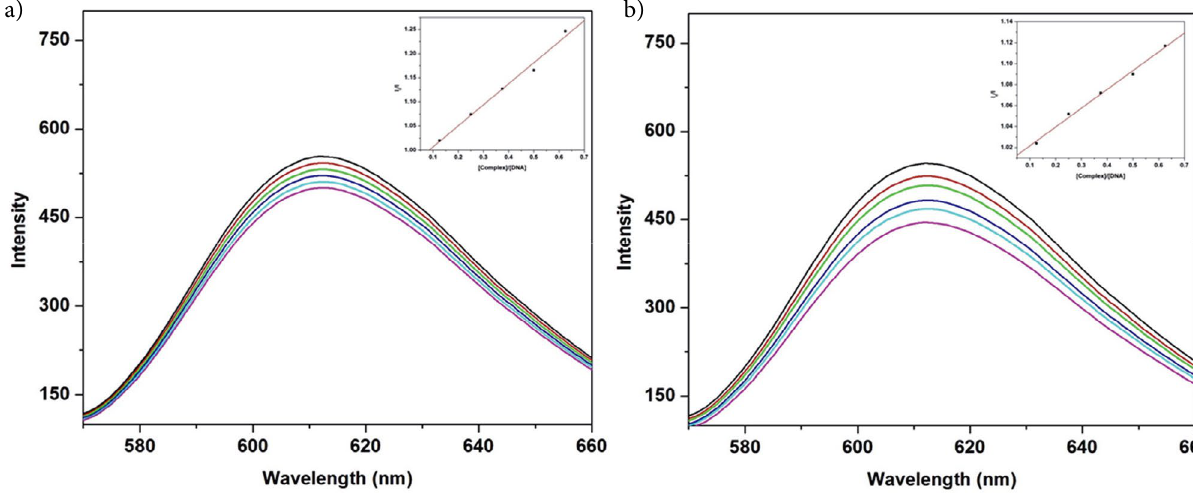
Fig. 2: Emission spectrum of EB bound to DNA in the presence of complexes ([EB] = 3.3 μM, [DNA] = 40 μM, [complex] = 0–30 μM, λ ex = 430 nm). Inset shows the plots of emission intensity I o / I vs [DNA] / [complex]. (a) Emission spectra of MnL complex (b) Emission spectra of FeL complex